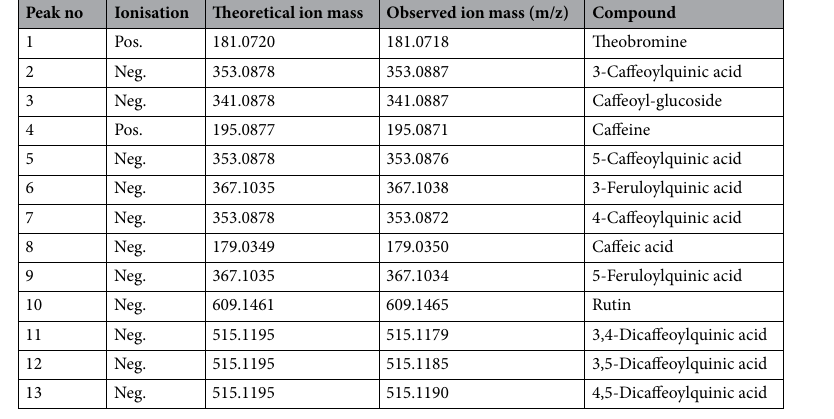
Table 1. Bioactive compounds detected using